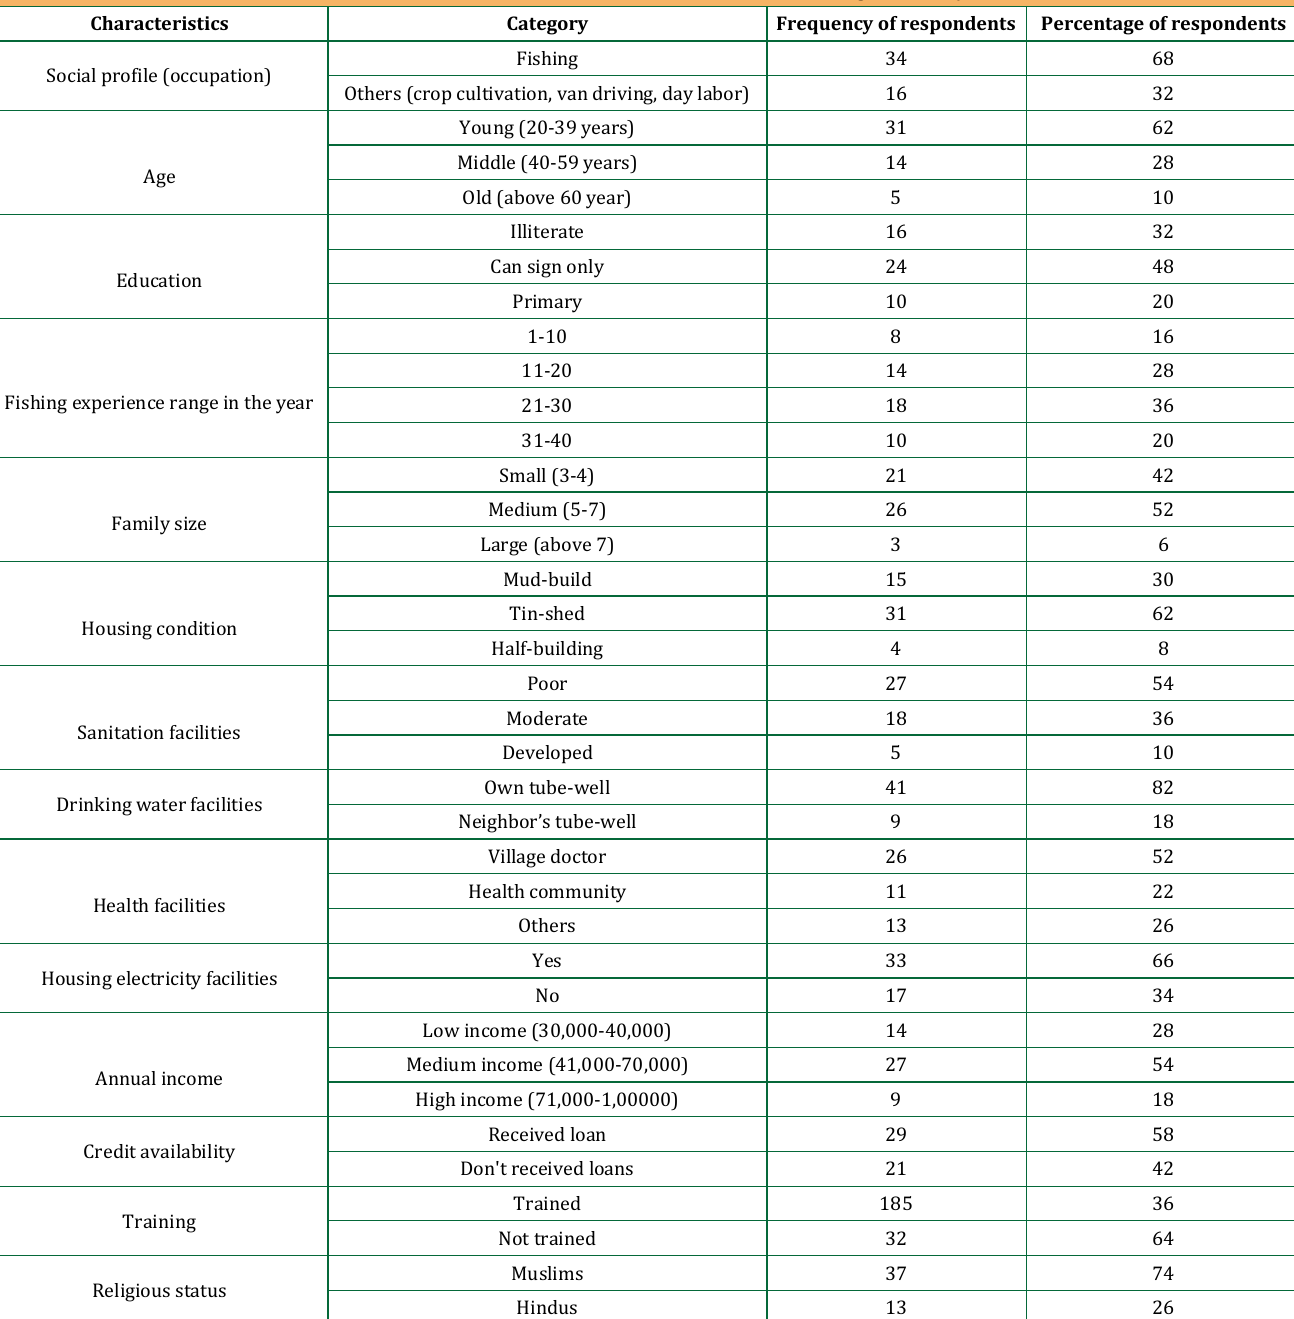
Table 3: Socio economic conditions of the Padma river’s fishing